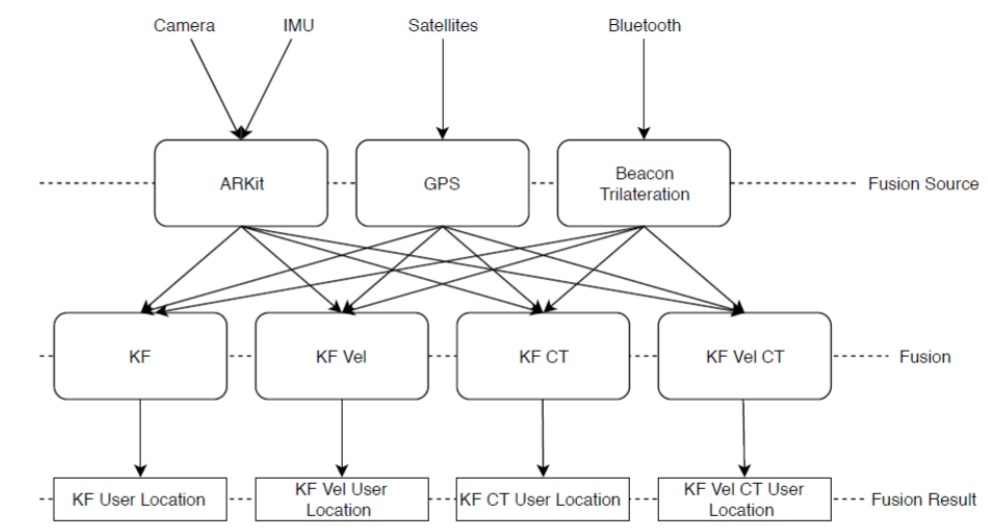
Figure 3. Overview of data